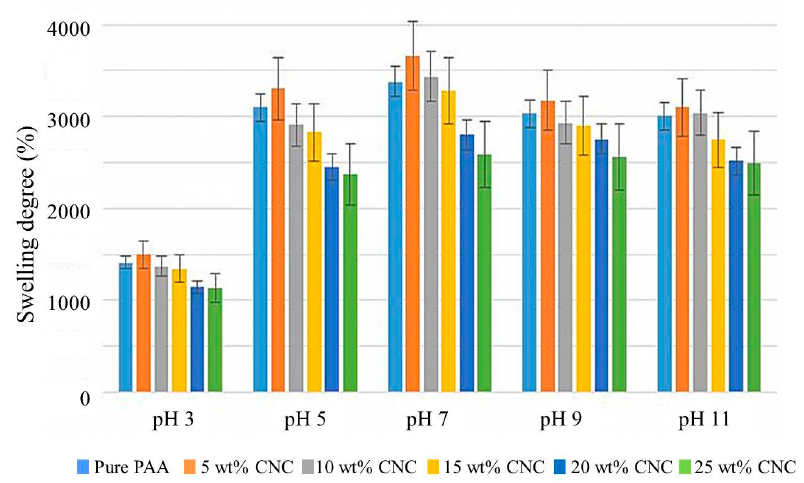
Figure 4. Swelling ratios of hydrogels with different CNC compositions, at pH 3, pH 5, pH 7, pH 9, and pH 11.